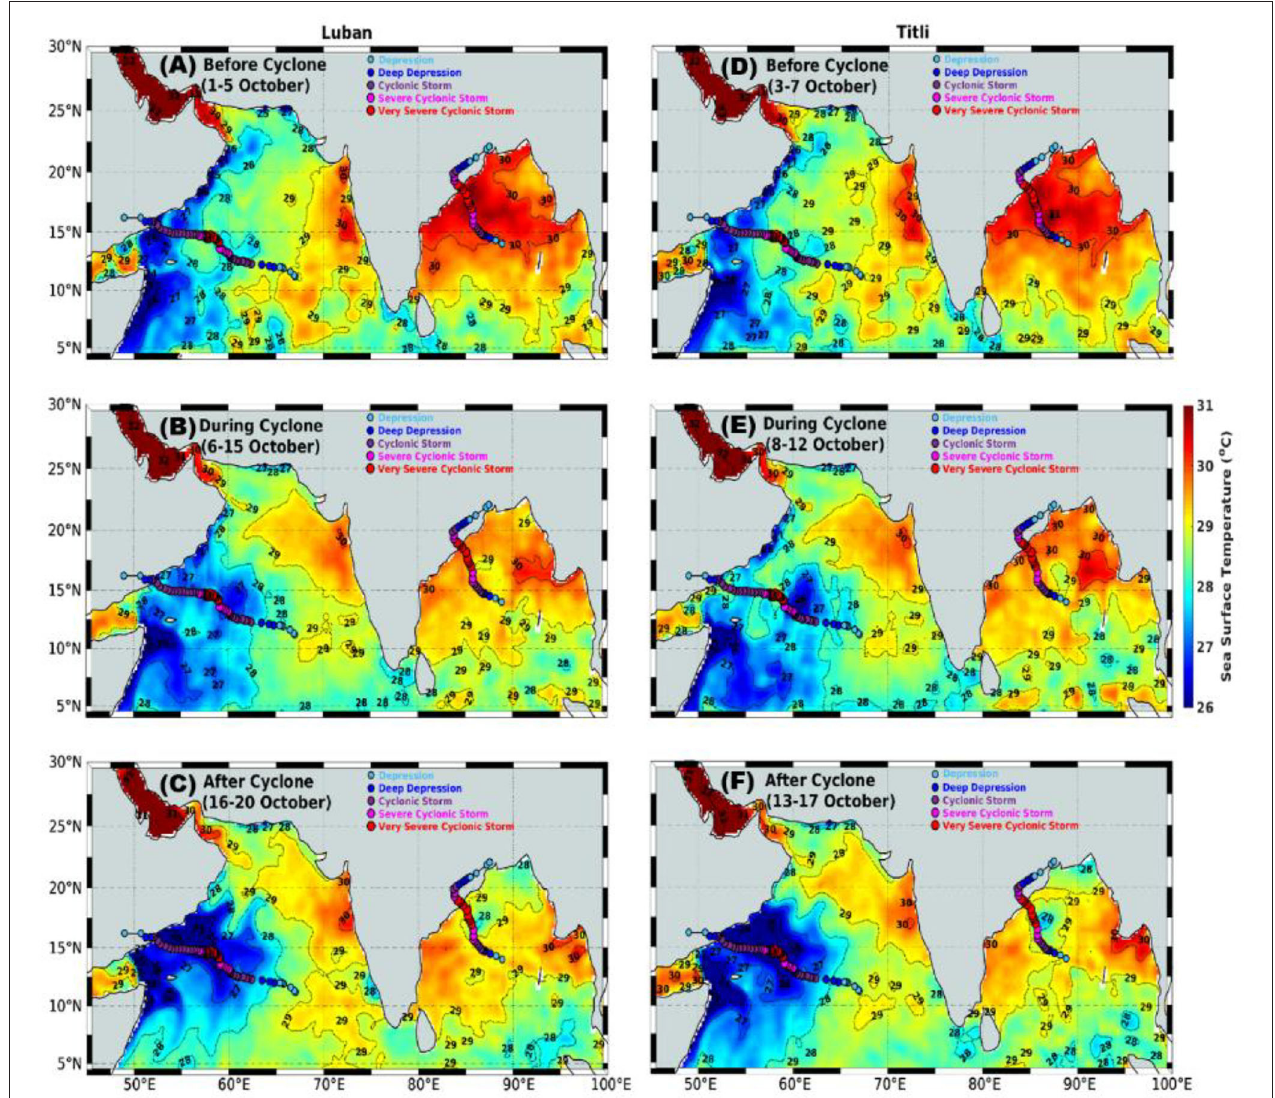
FIGURE 2 | Spatial distribution of the sea surface temperature (SST, ◦ C) before (A,D) , during (B,E) , and after (C,F) cyclones Luban (A–C) and Titli (D–F) , superposed with cyclone